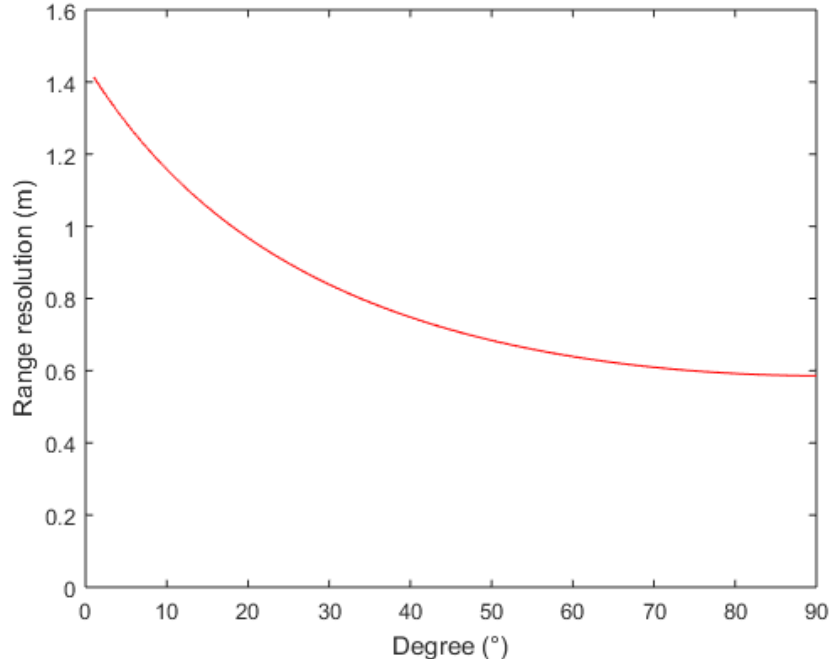
Figure 7. The range resolutions as a function of the zenith angle of a receiver.